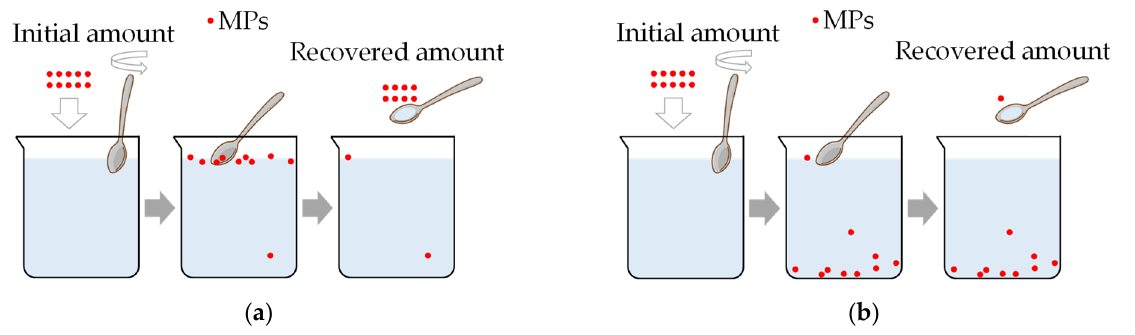
Figure 4. ( a ) Recovery of floating MPs; ( b ) recovery of sinking MPs.